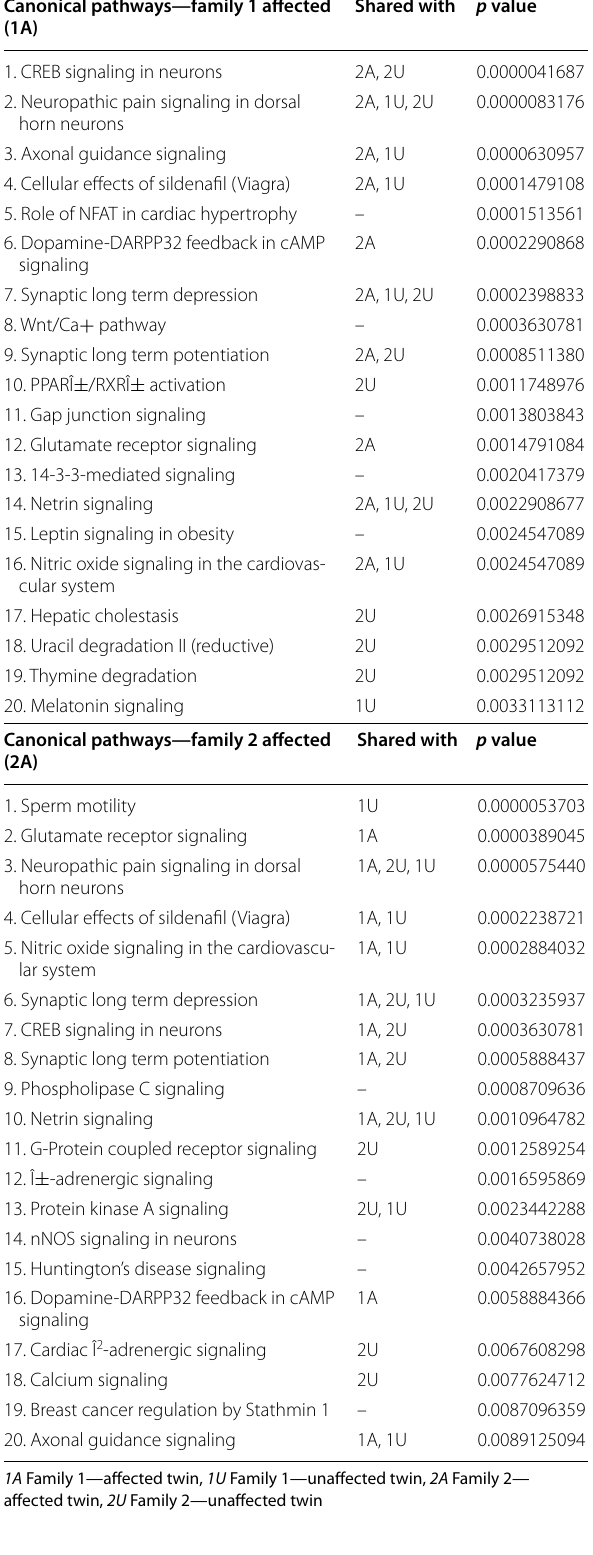
Table 10 Top 20 canonical pathways identified by ingenuity pathway analysis (IPA) in the affected twin of each